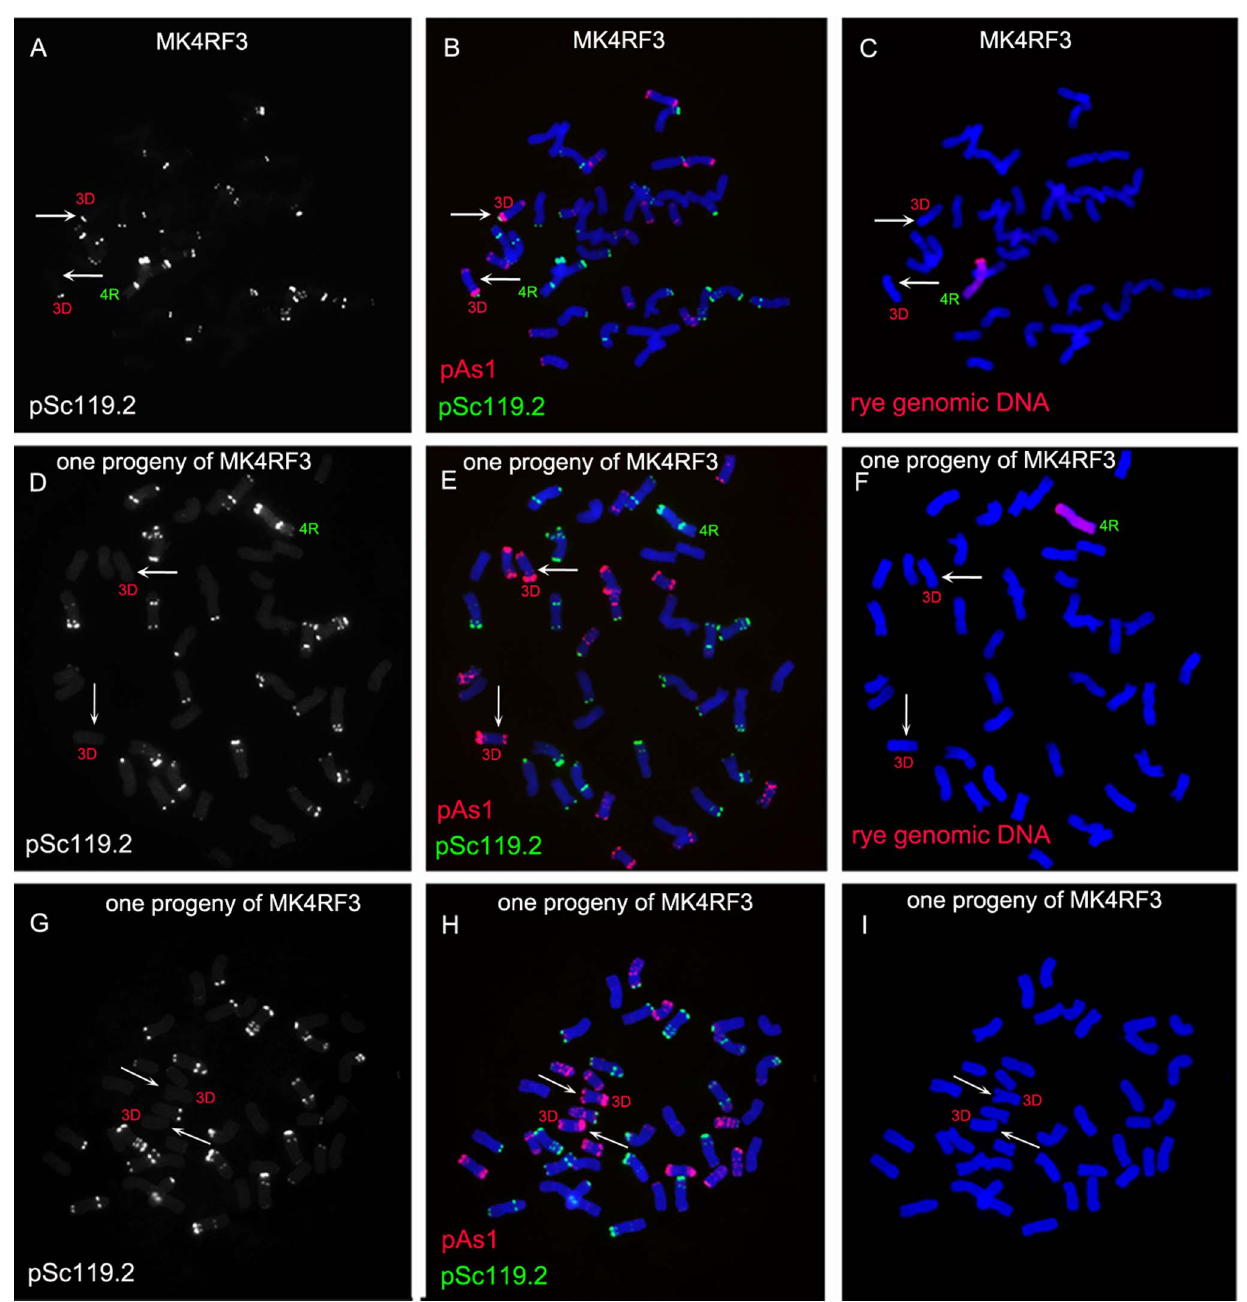
Figure 2. FISH and GISH using pAs1 (red), pSc119.2 (green) and rye genomic DNA (red) as probes on 4R monosomic addition line and its selfed progeny. A pSc119.2 FISH signals on chromosomes of MK4RF 3 , the DAPI-stained chromosomes were converted into a black and white image. B pSc119.2 and pAs1 FISH signals on the chromosomes of the same cell in A. C GISH analysis for the same cell in A and B. D pSc119.2 FISH signals on the chromosomes of one of the MK4RF 3 ’s progeny that was 4R monosomic addition line, the DAPI-stained chromosomes were converted into a black and white image. E pSc119.2 and pAs1 FISH signals on the chromosomes of the same cell in D. F GISH analysis for the same cell in E and D. G pSc119.2 FISH signals on the chromosomes of one of the MK4RF 3 ’s progeny that did not contain rye chromosome, the DAPI-stained chromosomes were converted into a black and white image. H pSc119.2 and pAs1 FISH signals on the chromosomes of the same cell in G.` GISH analysis for the same cell in G and H and no GISH signals are observed. Arrows indicate the 3D chromosome with or without pSc119.2 FISH signals. Chromosomes were counterstained with DAPI (blue).